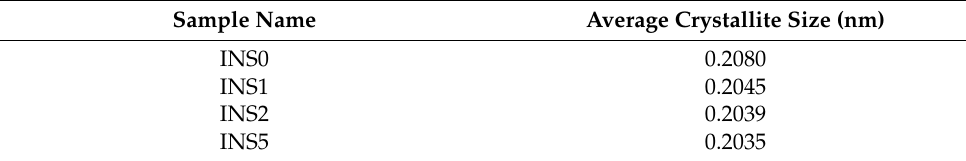
Table 1. Average crystallite size of INS